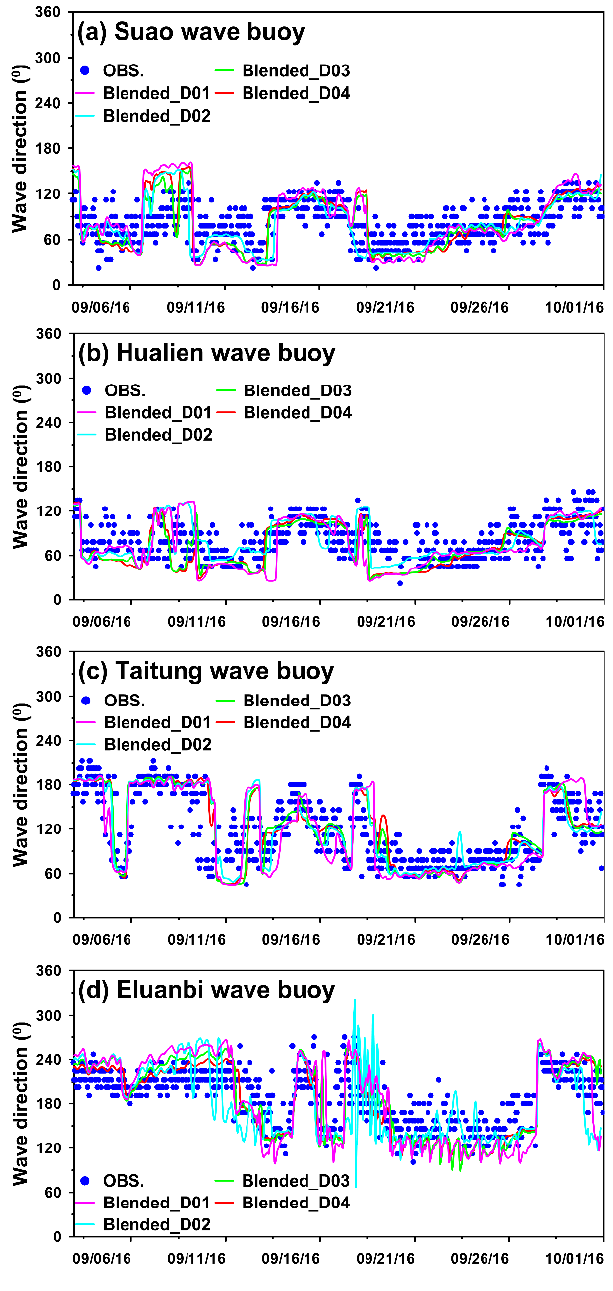
Figure 14. Comparison of the simulated and measured wave directions at the ( a ) Suao, ( b ) Hualien, ( c ) Taitung, and ( d ) Eluanbi wave buoys using the four computational domains and blended wind fields.